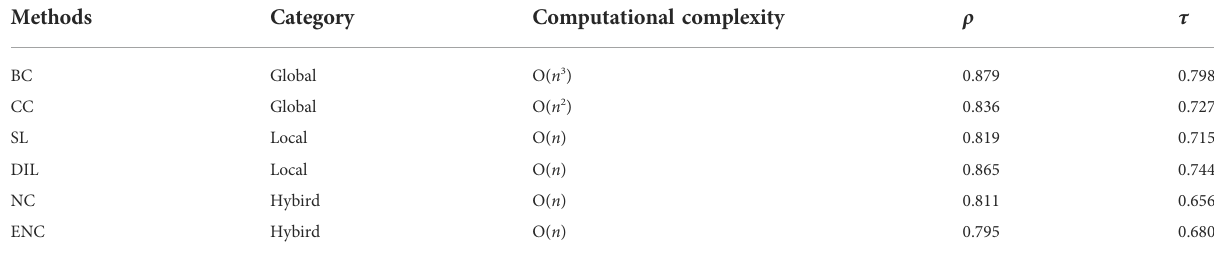
TABLE3Categoriesandcomputationalcomplexityofthesixmethodsandtheircorrelationcoef fi cientsoftherankingresultsusingtheNDMmethod, where ρ and τ denote the Spearman correlation coef fi cient and the Kendall correlation coef fi cient, respectively, and n denotes the number of nodes in the network.